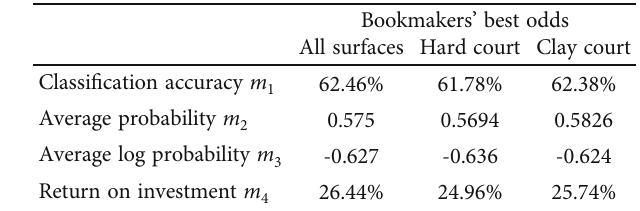
Table 9: Measures of predictive performance for bookmakers ’ best